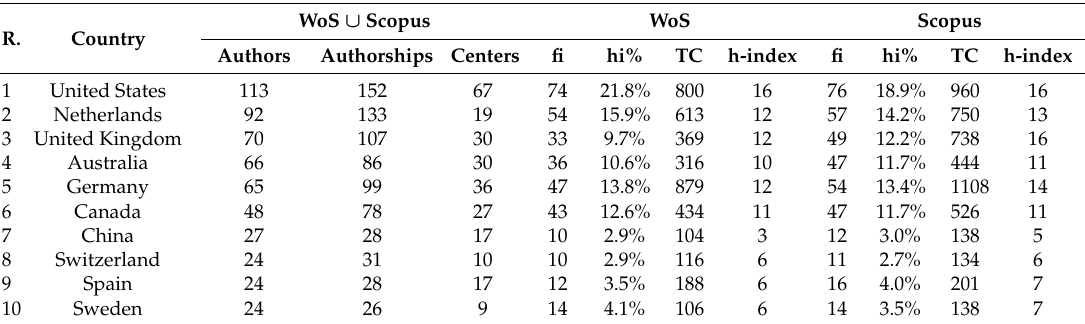
Table 4. Top ten countries by affiliation of researchers.